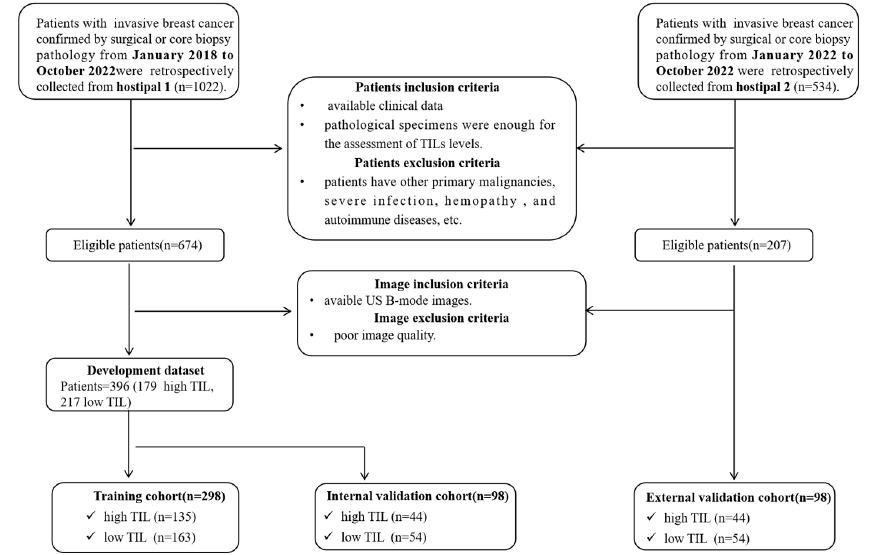
Figure 1. Patient selection flowchart; US, ultrasound; TIL, tumor-infiltrating lymphocyte.